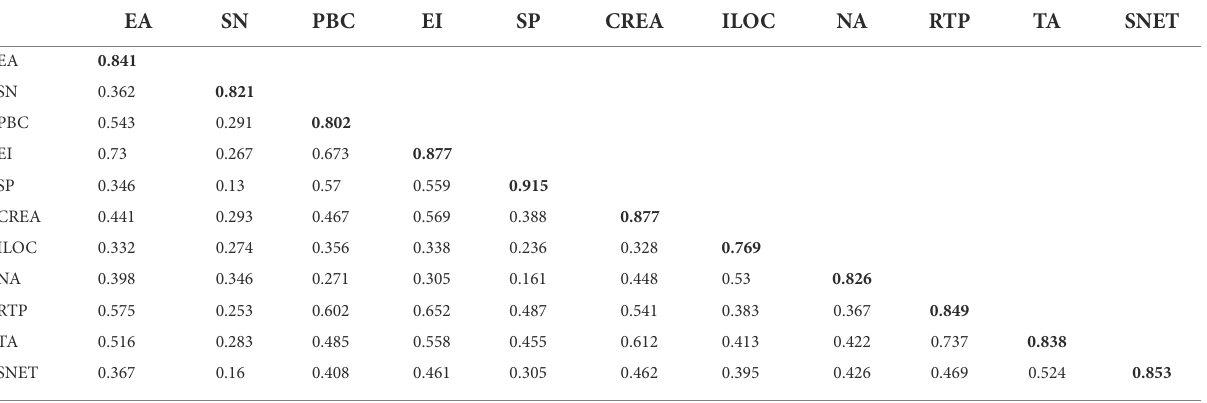
Values with bold font show the square root of AVE.